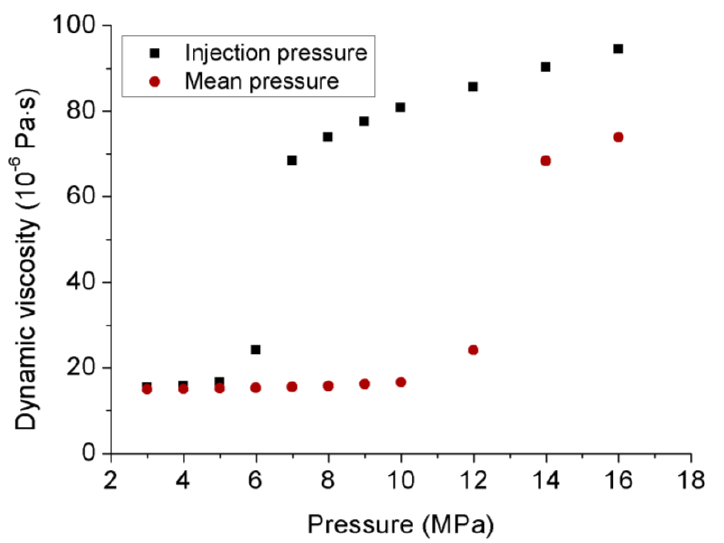
Figure 12. Relationship between CO 2 viscosity at different injection pressures.